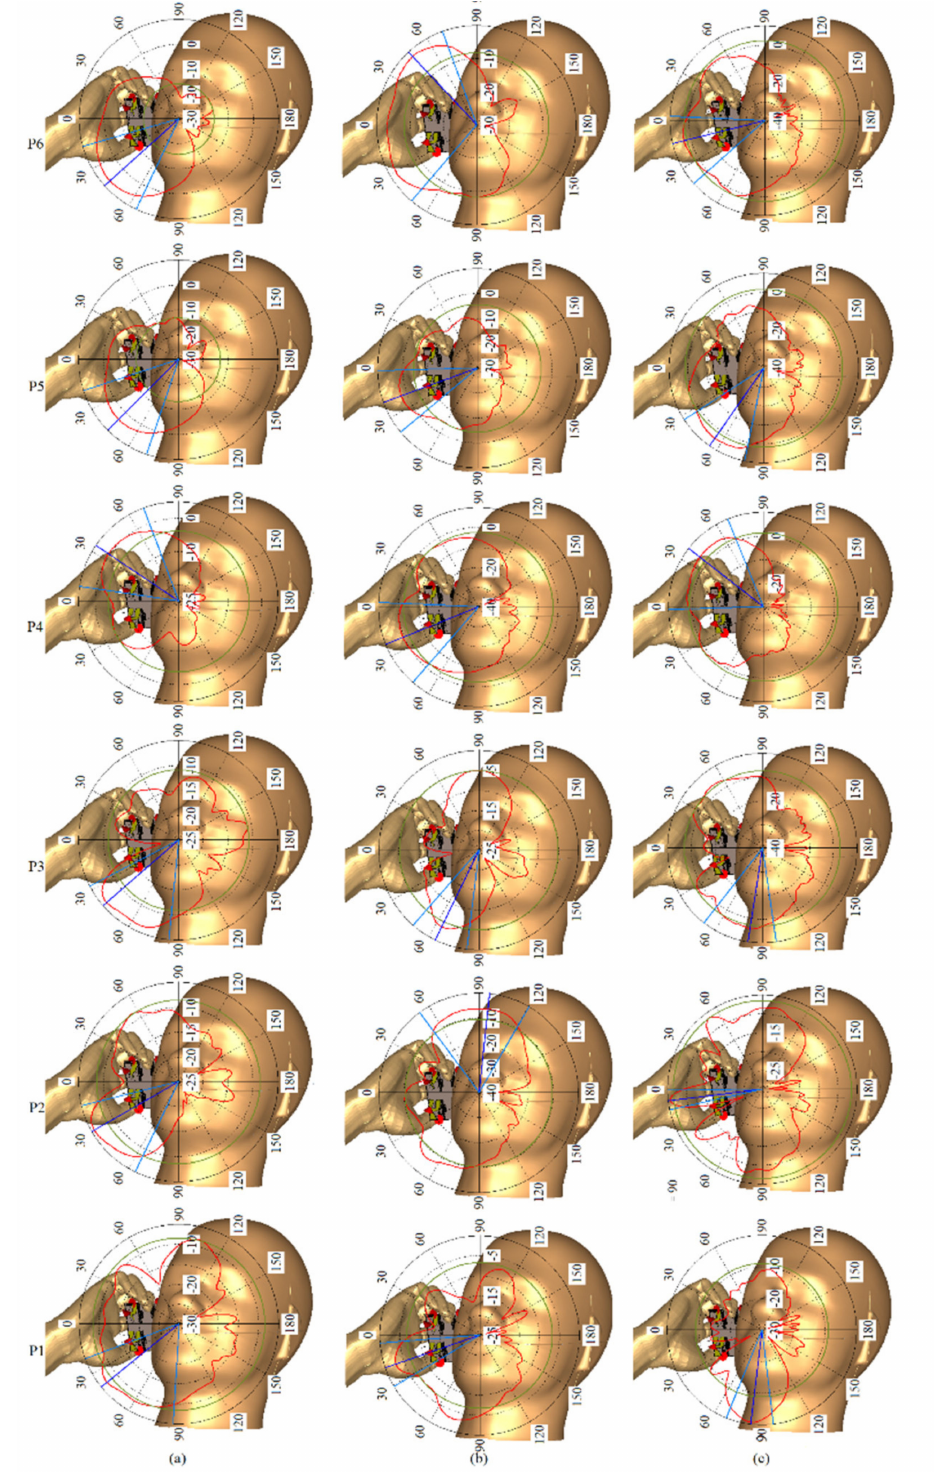
Figure 23. The 2D radiation pattern of the proposed MIMO with head and hand model: ( a ) at 3.8 GHz, ( b ) 5.2 GHz, and ( c ) 8.0